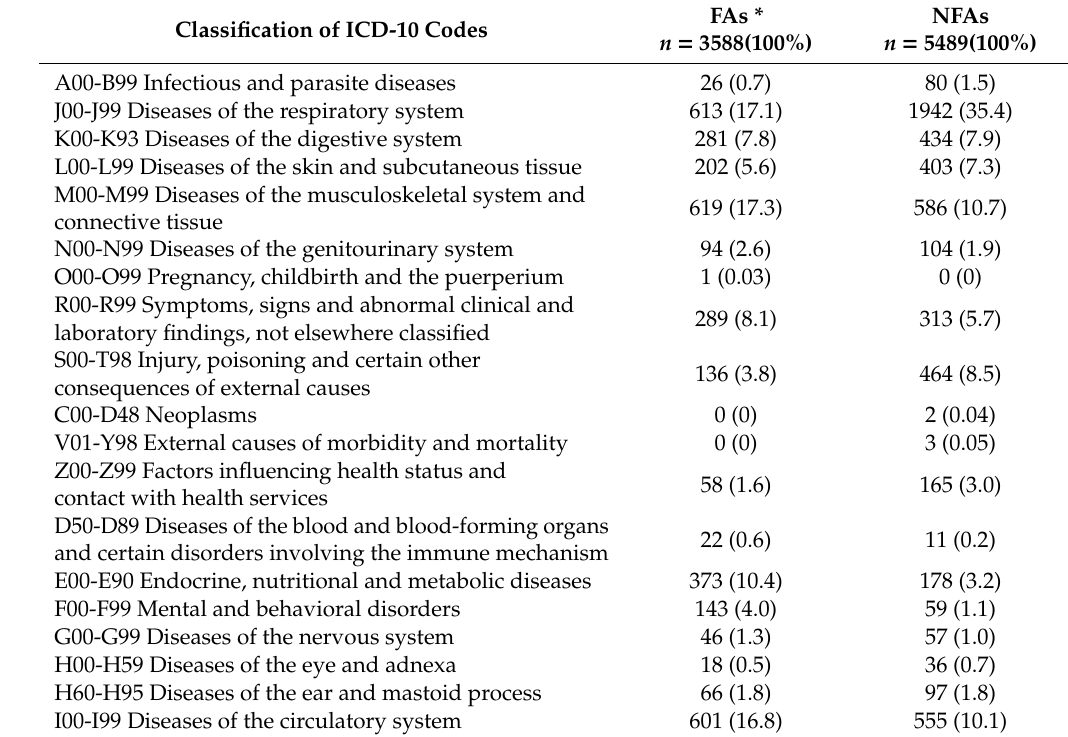
Table 3. List of the major diagnoses from subjects’ visits a .